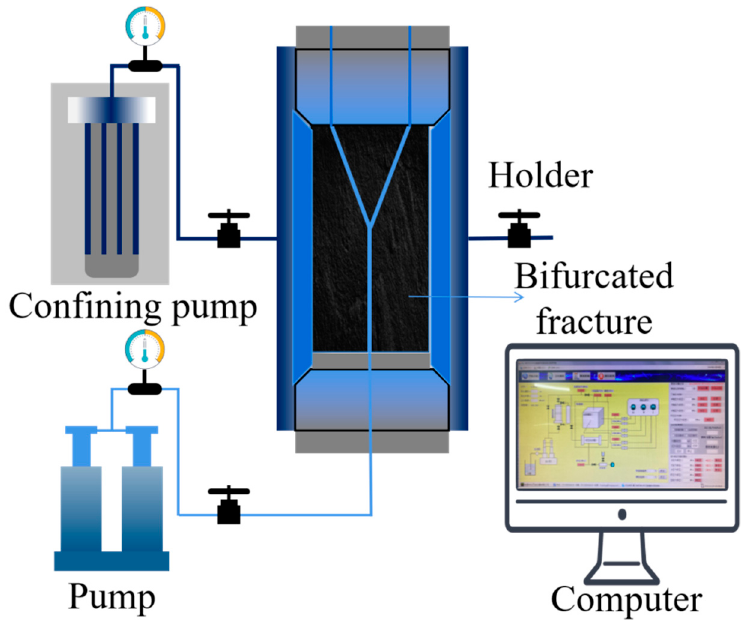
Figure 4. Diagram of the experimental equipment used in the tests.